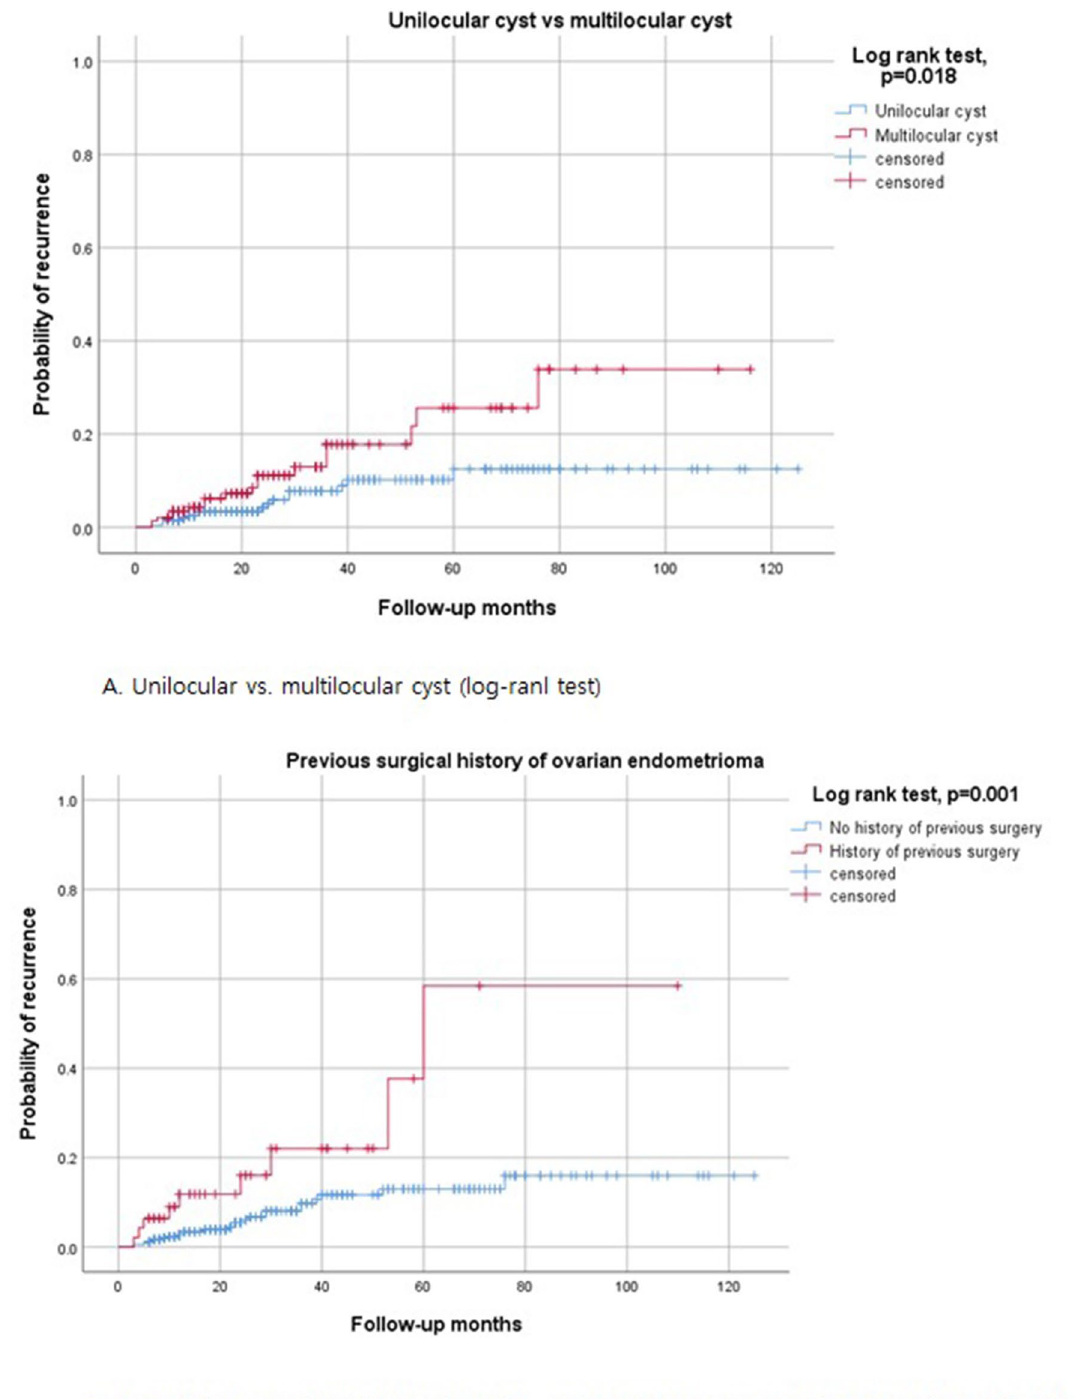
Figure 5. Kaplan-Meire curve of 3 possible risk factors for recurrent endometrioma on univariate analysis. (Log-rank